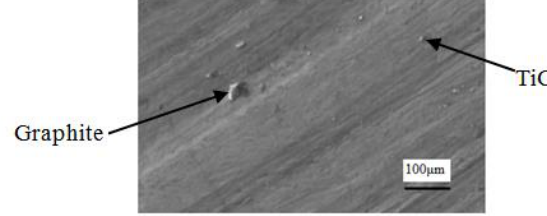
Fig. 4. Scanning electron microscope micrographs of Al6061-T6 + 5 wt percent titanium carbide + 5 wt percent graphite hybrid metal matrix composite.